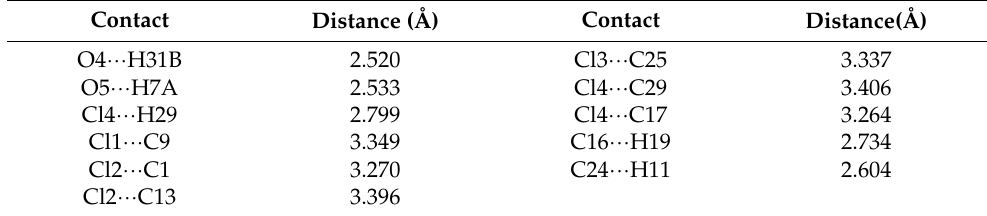
Figure 8. The fingerprint plots ( left ) and d norm maps ( right ) of the short contacts in complex 1 . Table 7. The distances of all short contacts in 1